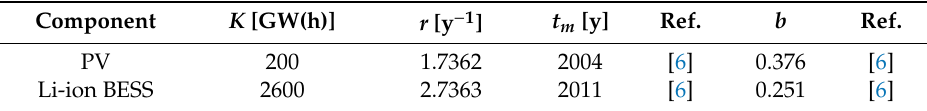
Table A2. Future cost parameters of energy